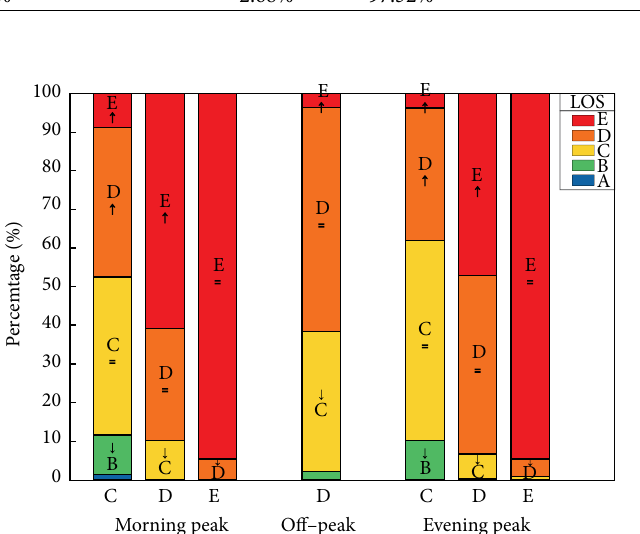
Figure 3: Percentage of TLOS change in each level on rainy days. The downgrades during morning peak is relatively larger compared to evening peak. The TLOS even slightly improved during off-peak when it